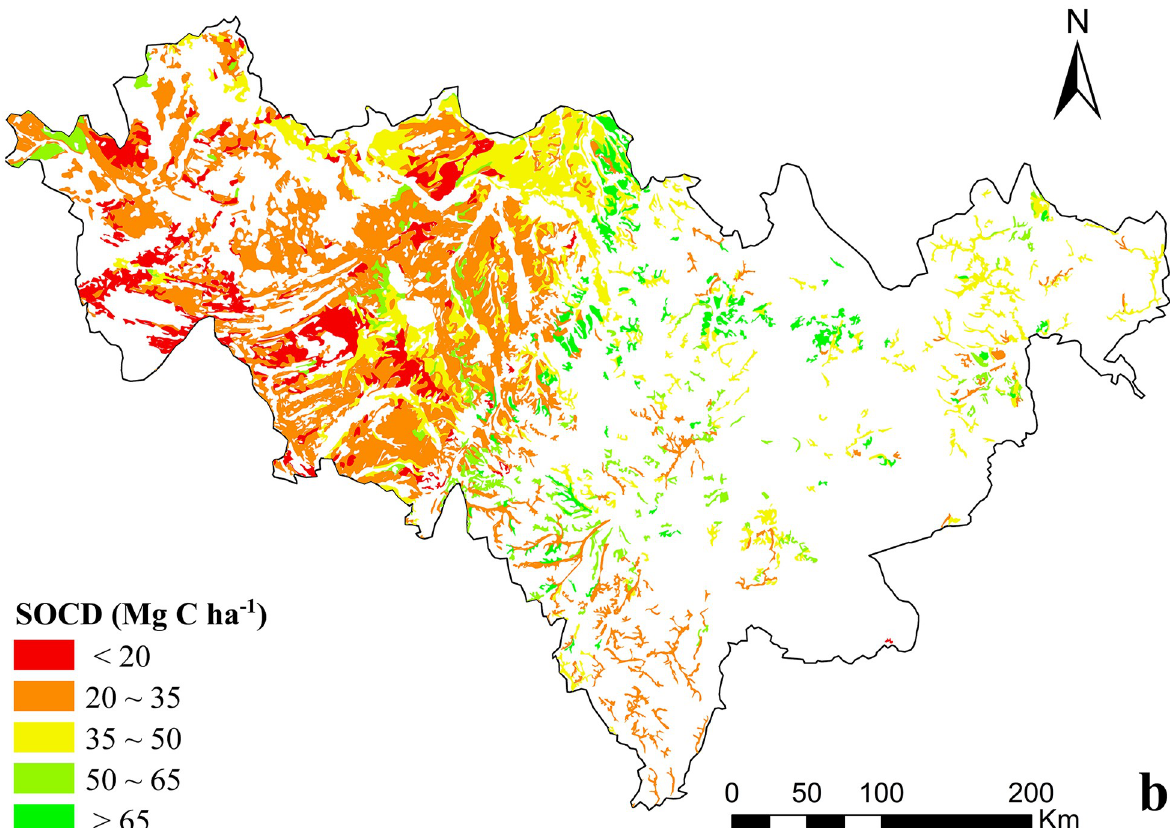
Fig 6. Spatial variability of SOCD of dry farmland in 2015, Jilin Province,